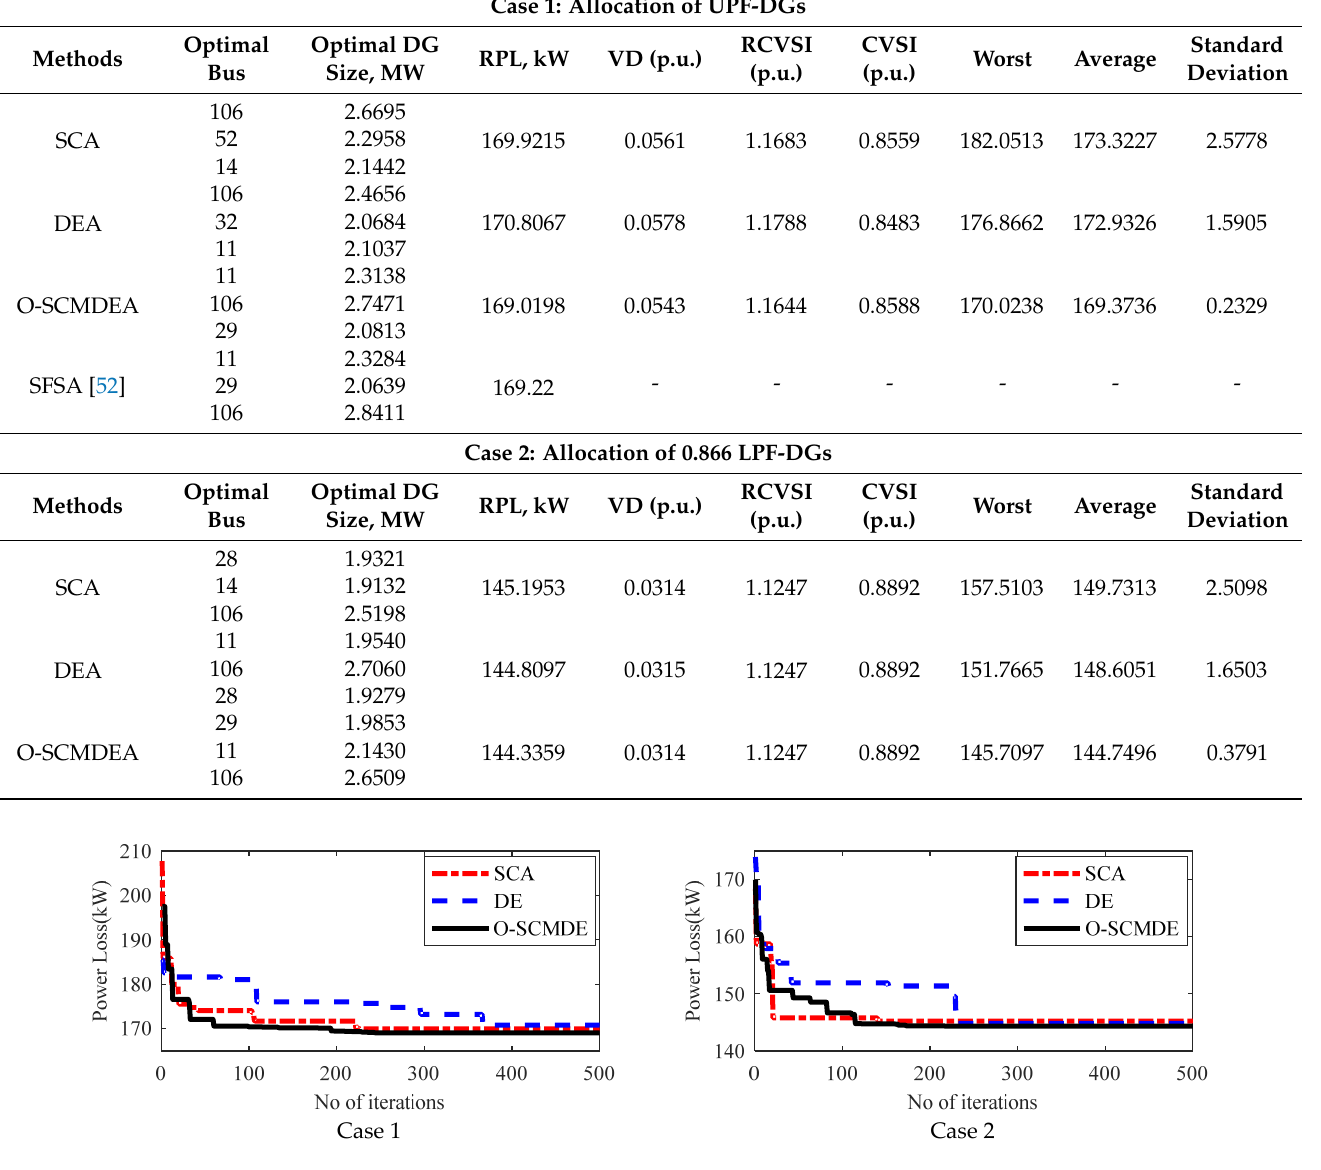
Table 12. Comparison of the results for real power loss minimization of 136 bus DN. Case 1: Allocation of UPF-DGs